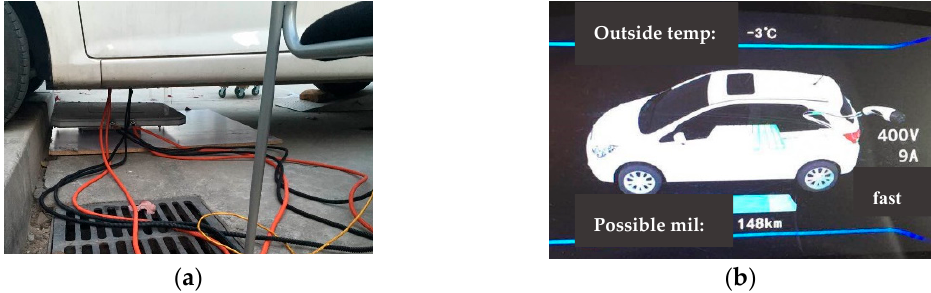
Figure 21. WCS experiment ( a ) Coupling coils; ( b ) Dashboard Information.